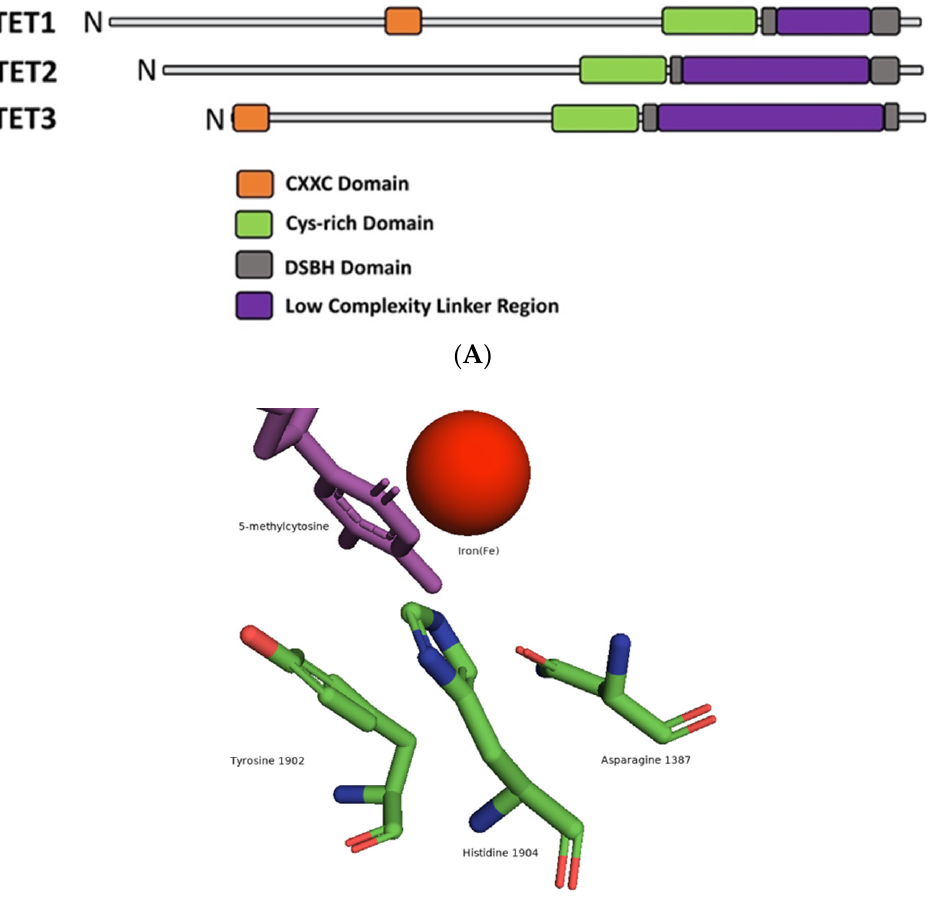
Figure 3. ( A ) Domain architecture of Human ALKBH2, ALKBH3. ( B ) Amino acid residues reside in close proximity to, and interact with, the flipped out modified cytosine base in ALKBH2 (PDB ID- 3BTZ).